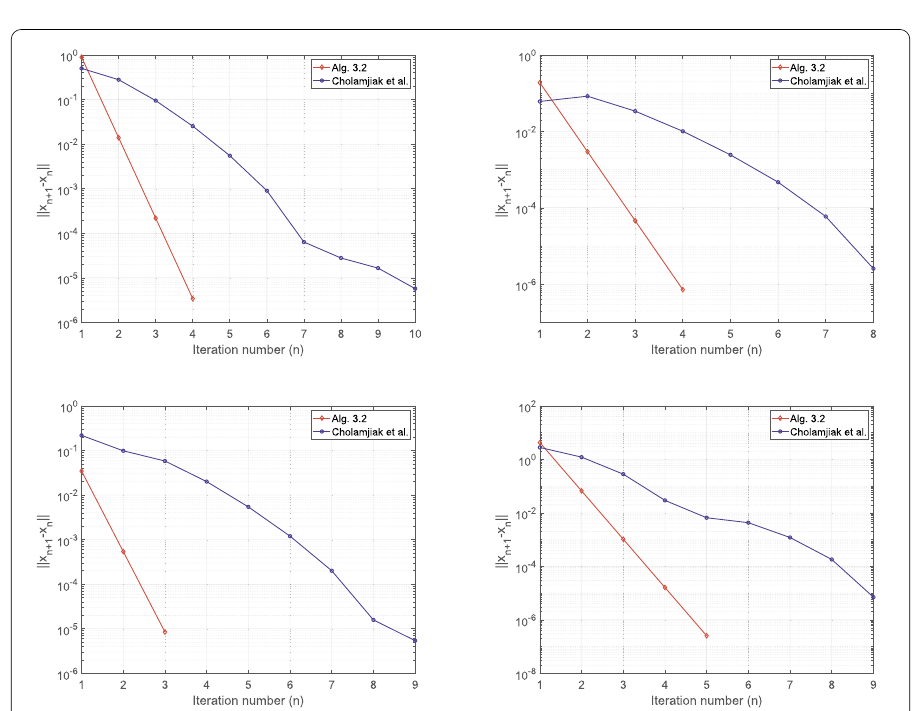
Figure 2 Example 4.2, Top Left: Case I; Top Right: Case II; Bottom Left: Case III; Bottom Right: Case